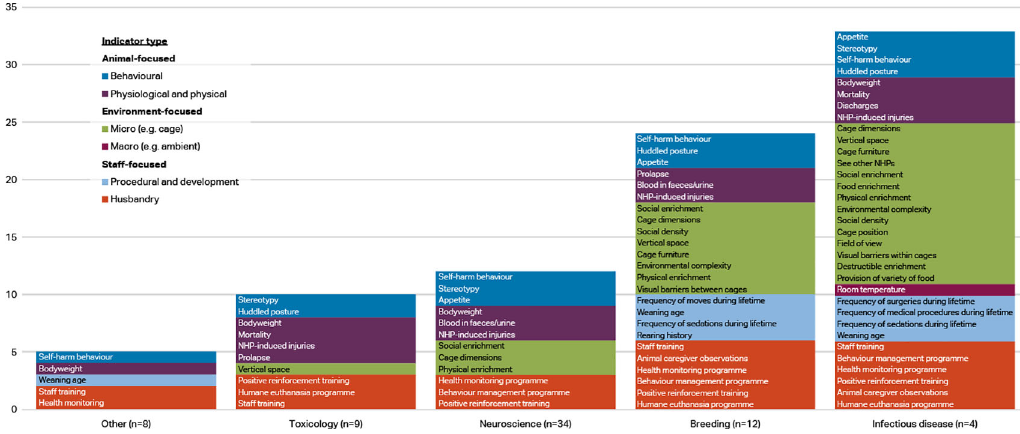
Figure 4. Indicators chosen as reliable and valid by two-thirds of respondents, macaques by discipline and indicator type (n=67